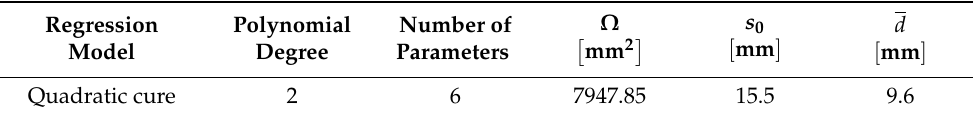
Table 10. Evaluation parameters of the 2nd degree regression model of the chimney axis based on the validation UAS-based data set.